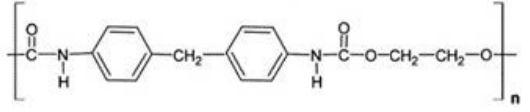
Figure 9. The chemical structure of PU.